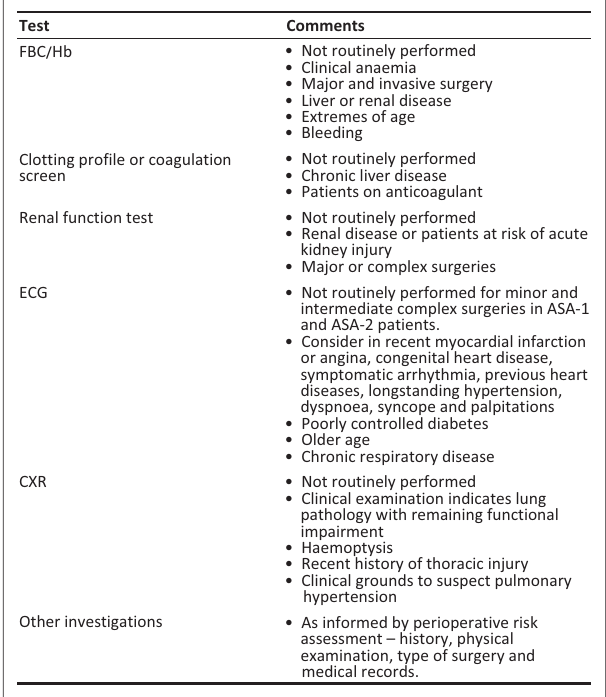
FIGURE 2: Pre-anaesthetic laboratory investigations in the district